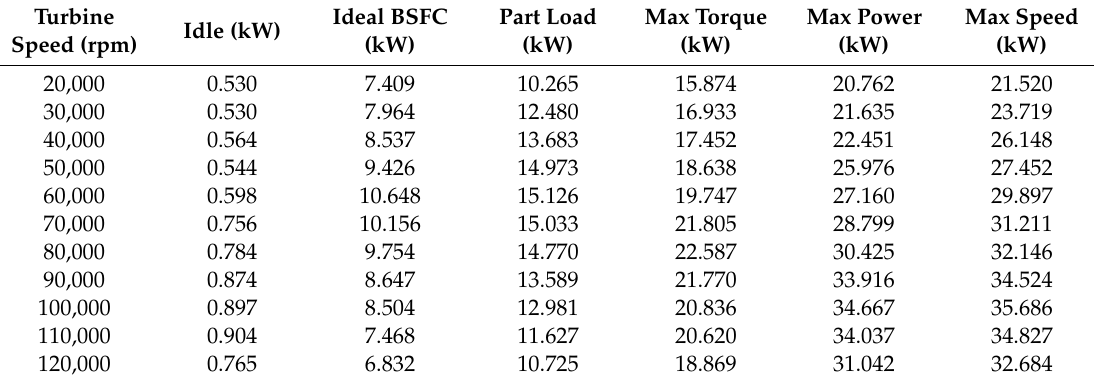
Table 5. Turbine analytical power output to speed variation.